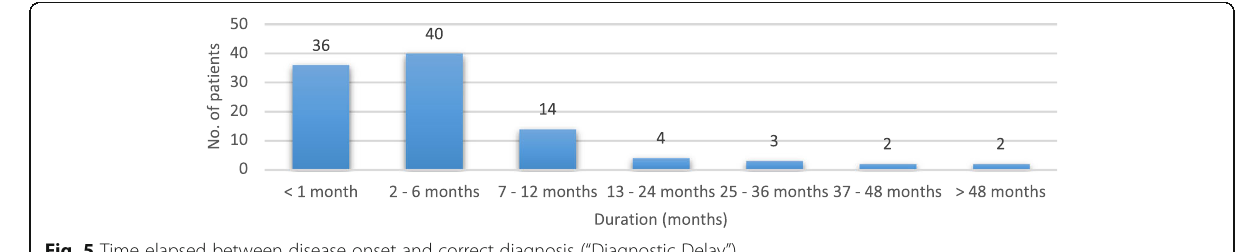
Fig. 5 Time elapsed between disease onset and correct diagnosis ( “ Diagnostic Delay ”